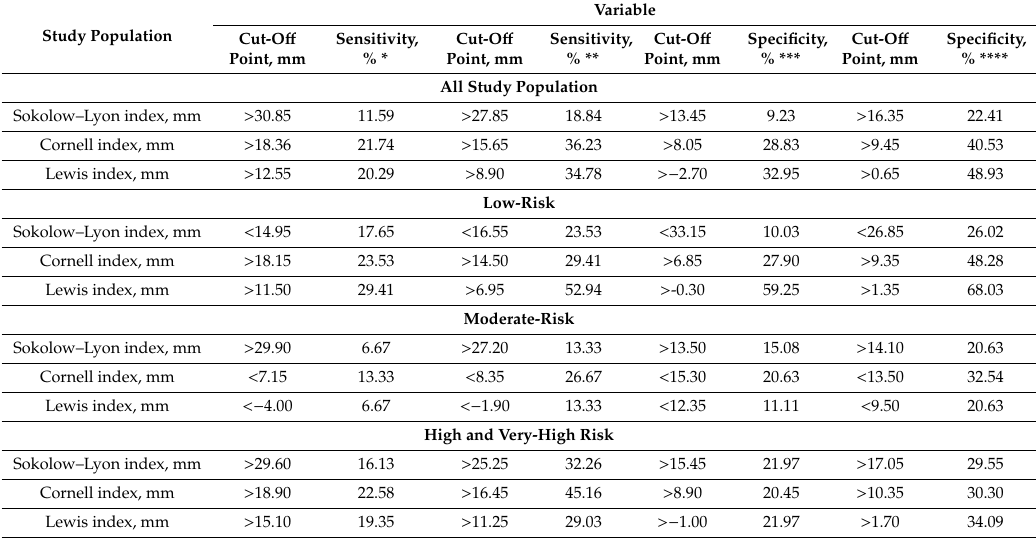
Table 7. Diagnostic accuracy of electrocardiographic criteria to detect the left ventricular hypertrophy in ECHO using LVMI BSA in the study population according to cardiovascular risk classes at di ff erent assumed sensitivities and